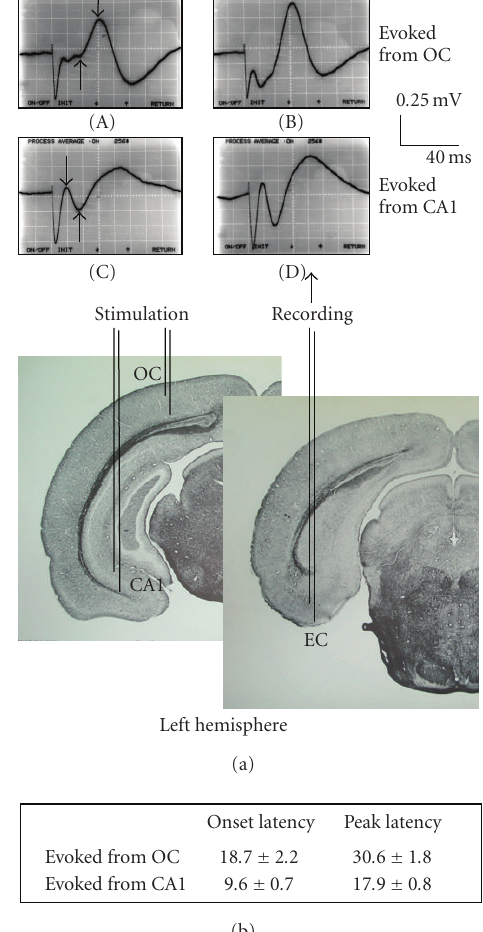
Figure 1: (a) Scheme of two coronal planes of the rat brain illustrating the positions of the stimulating electrodes in the occipital cortex (OC) and ventral CA1 region of the left hemisphere, as well as the location of the recording electrode in the ipsilateral entorhinal cortex EC. In the upper part are shown representative examples of the average of 30 successive responses evoked in the medial EC of one rat by ipsilateral stimulation of the occipital cortex (A and B) or the ventral CA1 hippocampal region (C and D) at 0.2Hz, obtained before (A and C) and after (B and D) tetanization. Calibration bars are indicated. Upward potential deflection is negative. First and second arrows indicate, respectively, the beginning and the peak of the early negative (A) or early positive (C) wave, which served to calculate peak amplitude or slope (amplitude/time ratio on the nearest sample to the 10% and the 90% level) of the early component. (b) Onset and peak latencies (values are means ± SEM, in millisecond) of the early component of EC responses to test stimulus applied to either the OC or CA1 region before